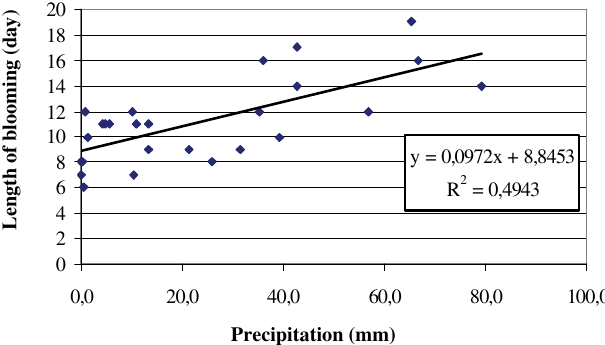
Figure 7. Relationship between the lenght of blooming and amount of precipitation during the bloming at “Kántorjánosi” cultivar (Újfehértó